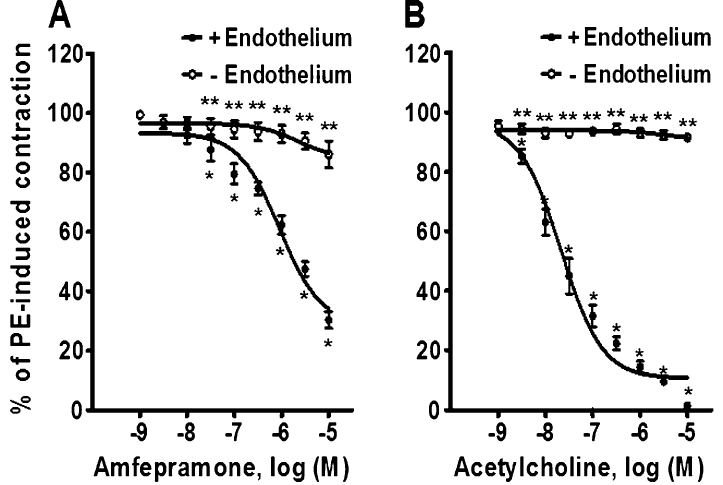
Figure 2. Concentration-dependent relaxation of 10 –9 -10 –5 M amfepramone ( A ) and 10 –9 -10 –5 M acetylcholine ( B ) in 10 –6 M phenylephrine (PE) precontracted rat aortic rings with (closed circles) and without (open circles) endothelium. Data are reported as means±SE of n=6 observations. *P , 0.05 vs basal phenylephrine-induced con- traction; **P , 0.05 vs rings with endothelium (two-way ANOVA).